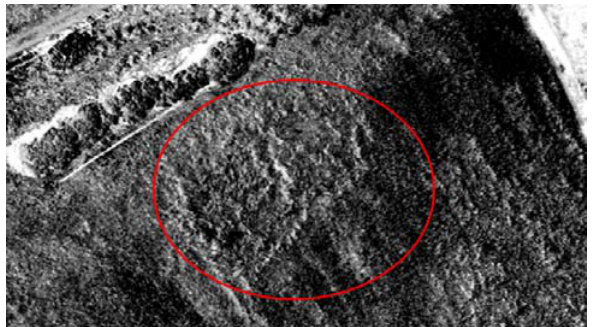
Figure 9. Image enhancement of the image applied to the IRG vegetation